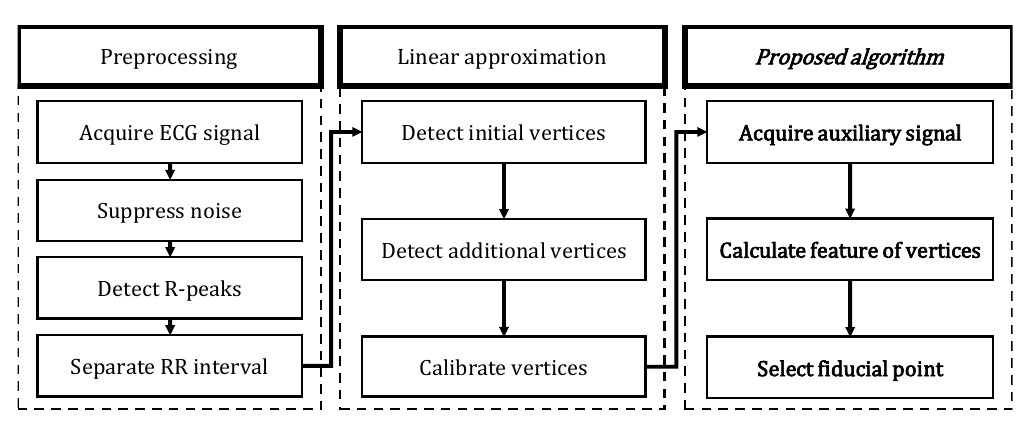
Figure 9. Algorithm flowchart.